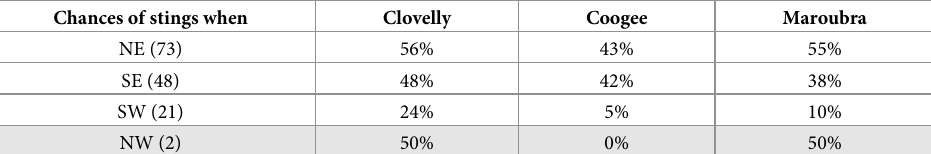
Table 4. Frequency of summer stings per wind sector. Computed on data 24 hours before a report, on summer months only, from 2016 to 2020. The 4 sectors: North-East (NE), South-East (SE), South-West (SW) and North-West (NW) are redefined following the orientation of the coastline (see windrose of Fig 1). After each wind sector the num- ber of instances that wind blew from this direction is written in parentheses. NW results will not be considered as there are only 2 reports available for this wind direction. Chances of stings